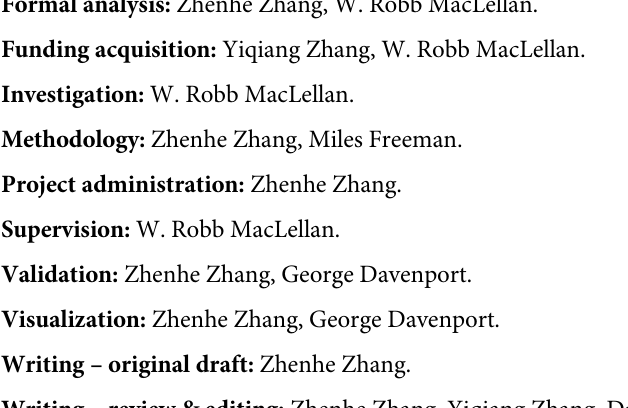
binding site analysis on the common cell cycle transcription factors promoter. The promoter sequence was analyzed from -1500 to +500. Red bars represent E2F1 binding site, blue bars represent Myc binding site, and green bars represent TEAD binding site. (D) KEGG pathway analysis between control and iKDM4D by DAVID Bioinformatics Resources. The number of genes is represented on the x-axis and the KEGG pathways are listed on the y-axis. S1 Table. DEGs in iKDM4D group compared to Sav1-sh. S2 Table. Upregulated DEGs in group Sav1-sh compared to control. S3 Table. Upregulated DEGs in group iKDM4D compared to control. S4 Table. Upregulated DEGs in both Sav1-sh and iKDM4D. S5 Table. Primers used in this